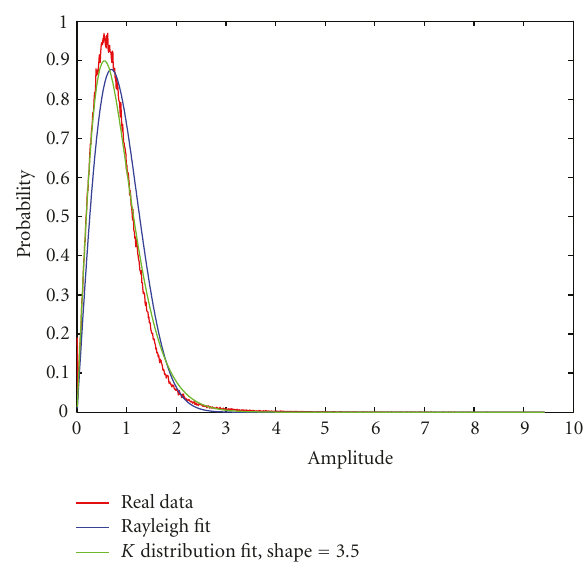
Figure 2: Histogram of real-data distribution and plots of Rayleigh and K distribution probability distribution functions with variance and/or shape parameter matched to real